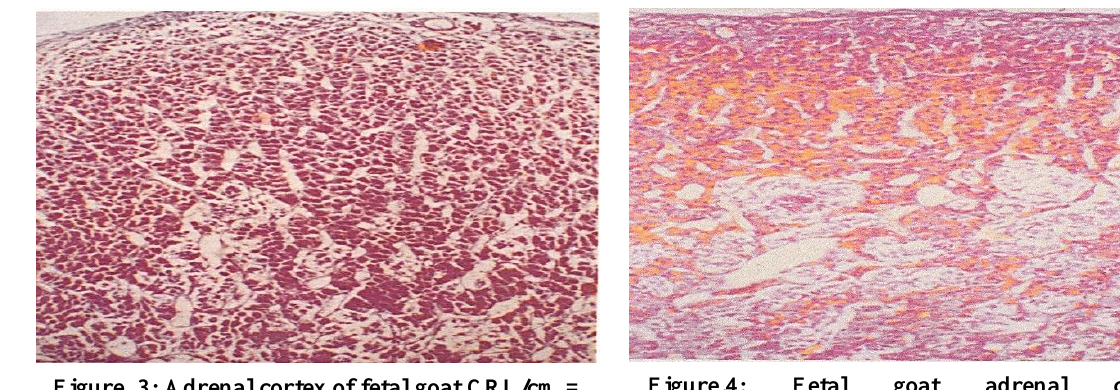
Figure, 3: Adrenal cortex of fetal goat CRL/cm = 35,120 day ; The cortex surrounded with capsule contain blood vessels. Zona glomerulosa cells are small , deeply stained and arranged in bull like cluster . The zone s of fascicularis and reticulate appears with large nucleus. ( M. H. X80).